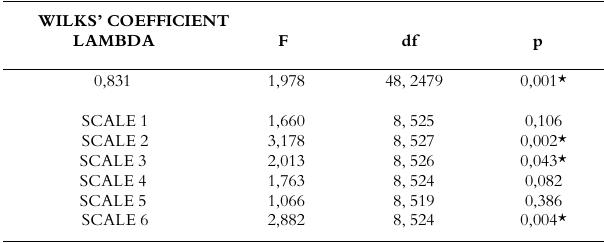
TABLE12 MANOVA ANDASSOCIATEDANOVAS: COMPARISONOF THE MEANSOF